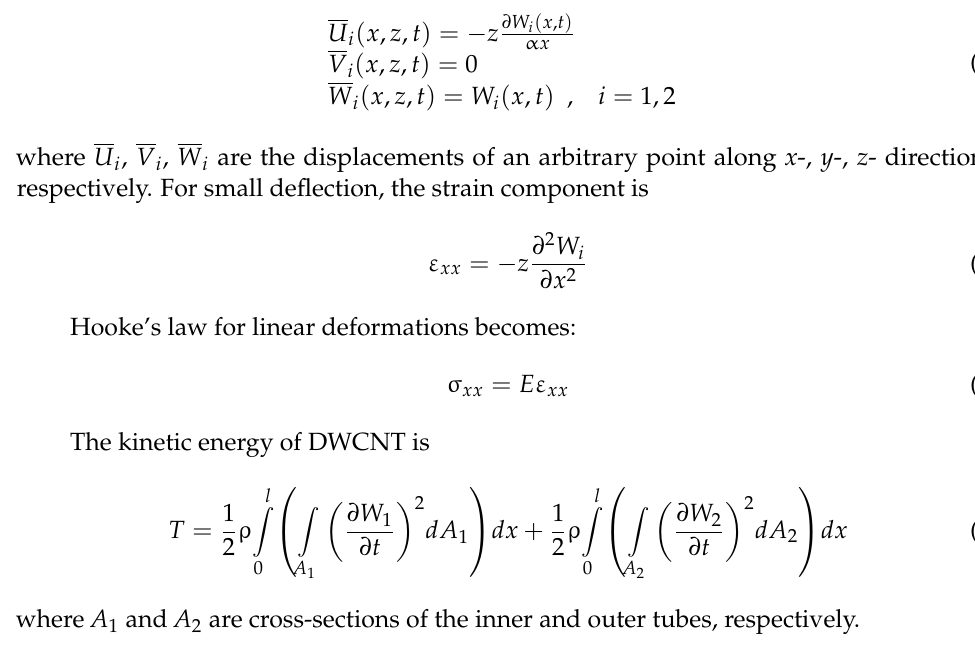
where T , Π and W NP are kinetic energy, potential energy (which include the strain energy of nanotube, potential energy from Winkler–Pasternak foundation and potential energy due to van der Waals forces) and the work done by the moving nanoparticle m, respectively. The Euler–Bernoulli theory supposes that the vector perpendicular to the neutral axis x of the beam remains perpendicular after deformation and accordingly, the deformation due to shear stress is neglected. Also, the longitudinal displacement of the beam can be neglected.